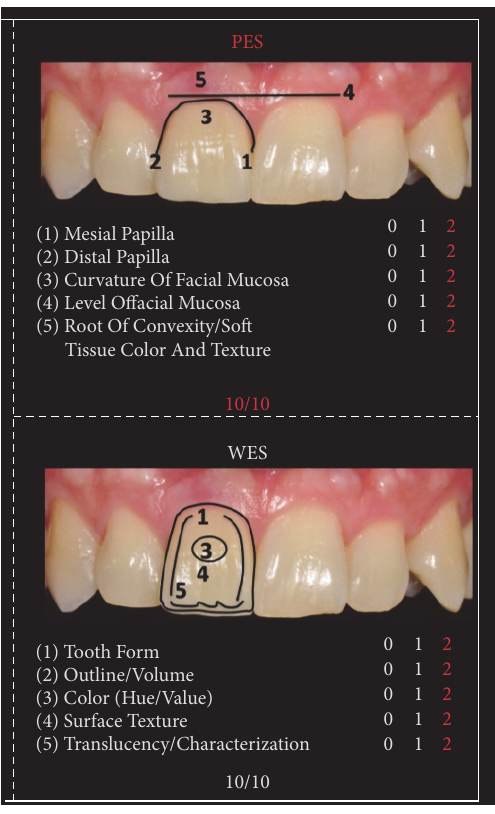
Figure 2: Initial PES/WES. Figure 3: Final